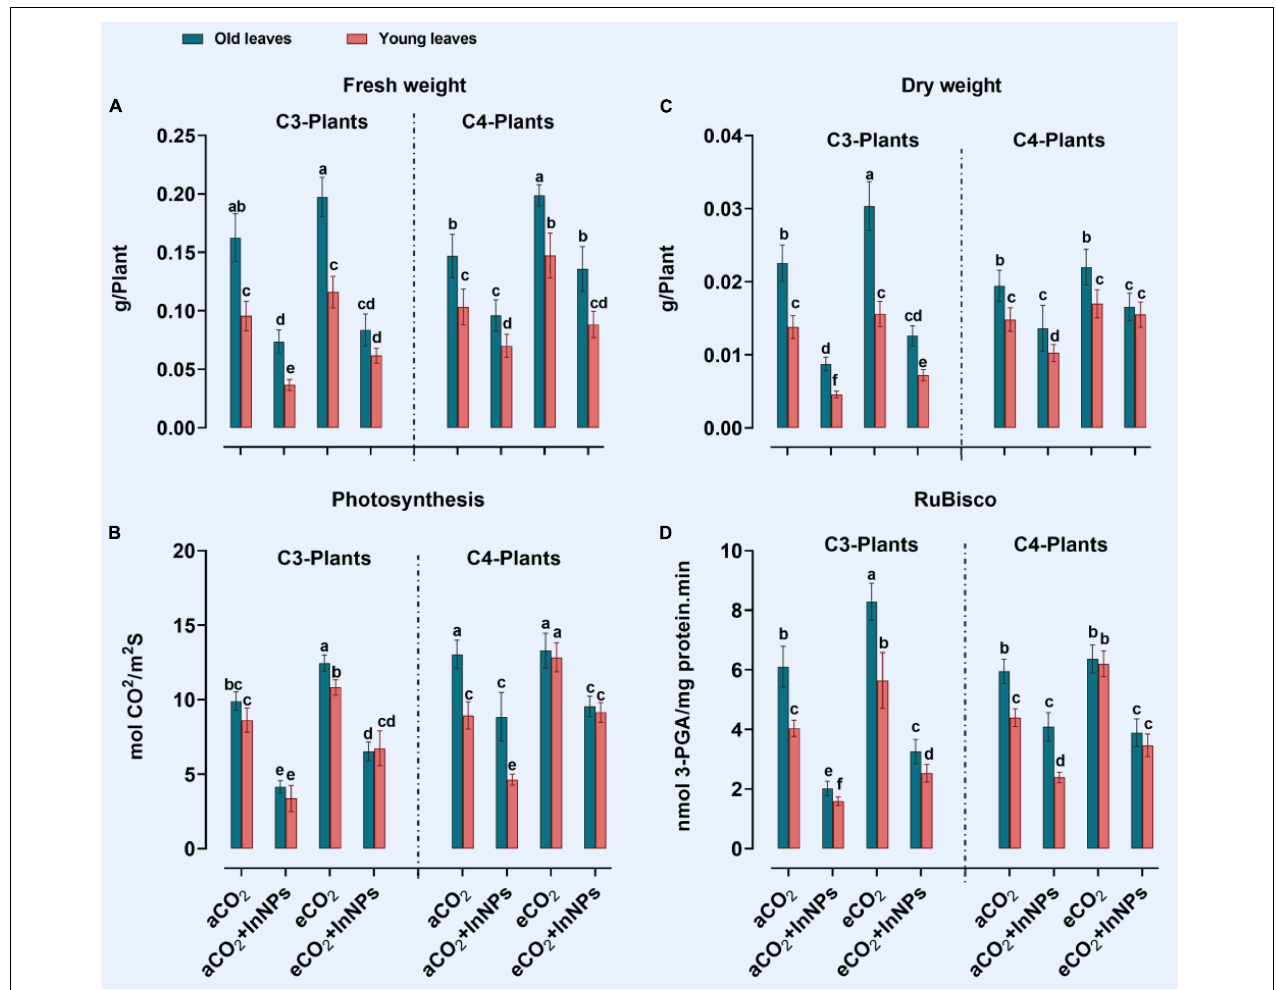
FIGURE 1 | (A–D) Effect of the co-application of future climate CO 2 and In 2 O 3 -NPs upon the biomass (FW and DW) and photosynthesis of both old and young leaves of C3 and C4 plants. Four biological replicates are used to measure each value. The bars on the columns represent error bars (SE). One way ANOVA test (P < 0.05; n = 4) was applied to show the significant difference between groups. Different letters showed the significant difference between